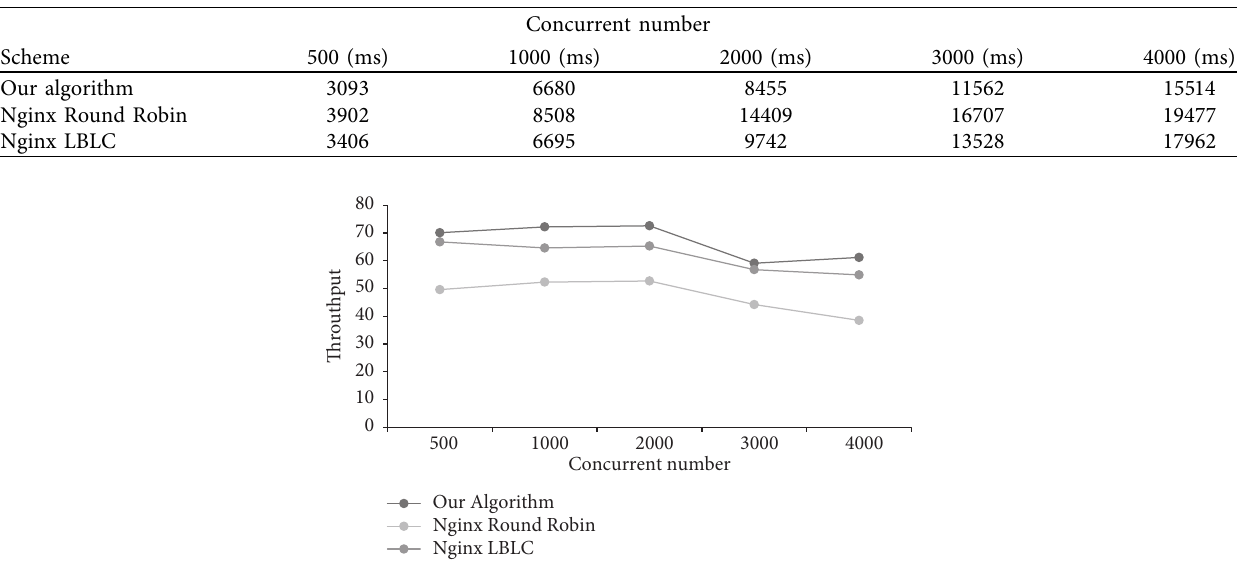
Figure 9: Throughput comparison of three schemes.